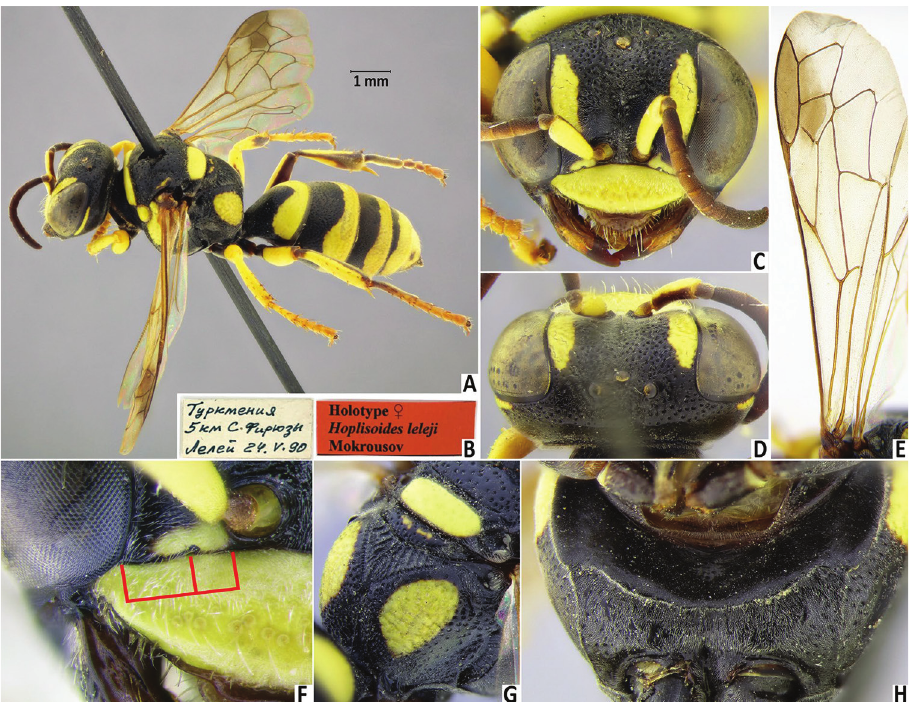
Figure 3. Hoplisoides leleji Mokrousov, sp. nov., holotype, female: A habitus, dorsolateral view B labels C head, frontal view D head, dorsal view E fore wing, dorsal view F tentorial pit and adjacent area, frontal view G scutellum, metanotum and propodeum, posterolateral view H metasoma, ventral